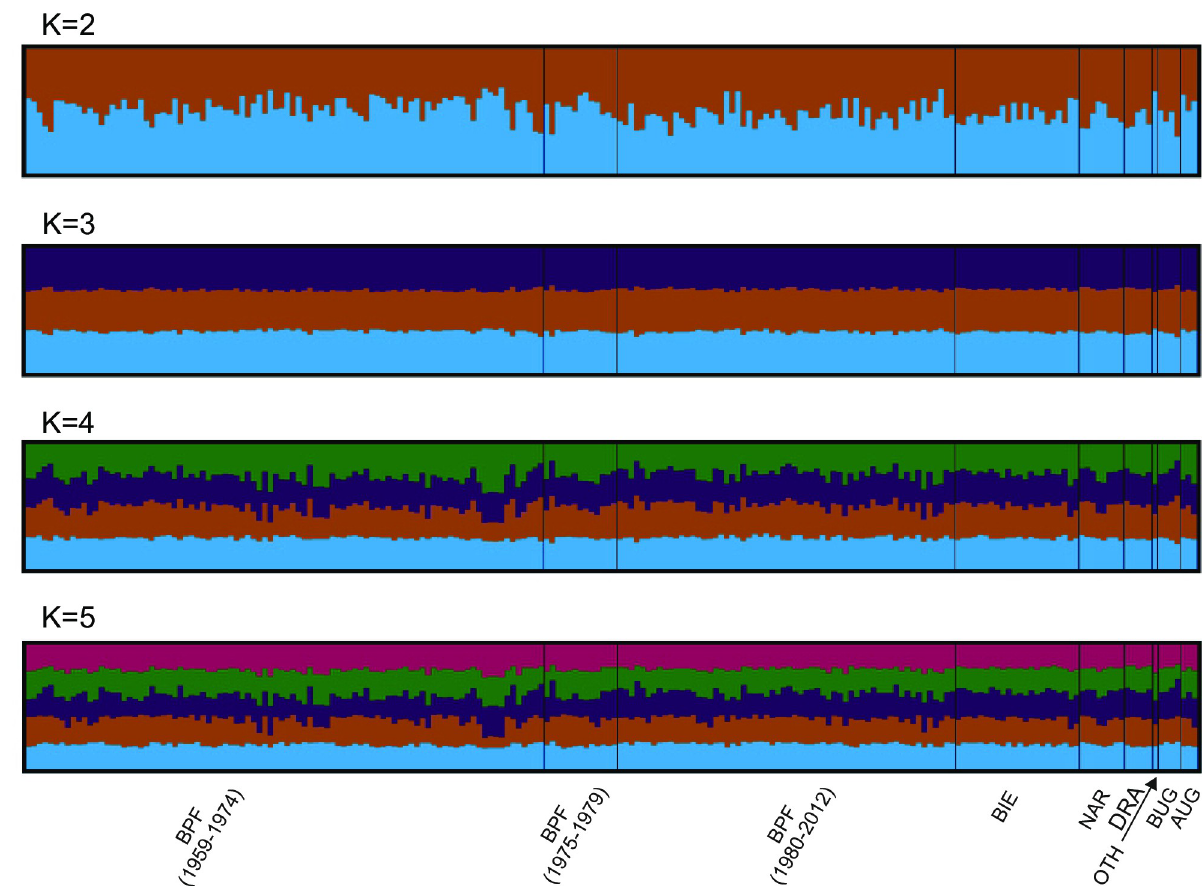
Fig 3. Population structure inferred from microsatellite data using the software package STRUCTURE. Each output represents the matrix of membership coefficients averaged over 40 independent runs with CLUMPP. Acronyms as in Fig 1.